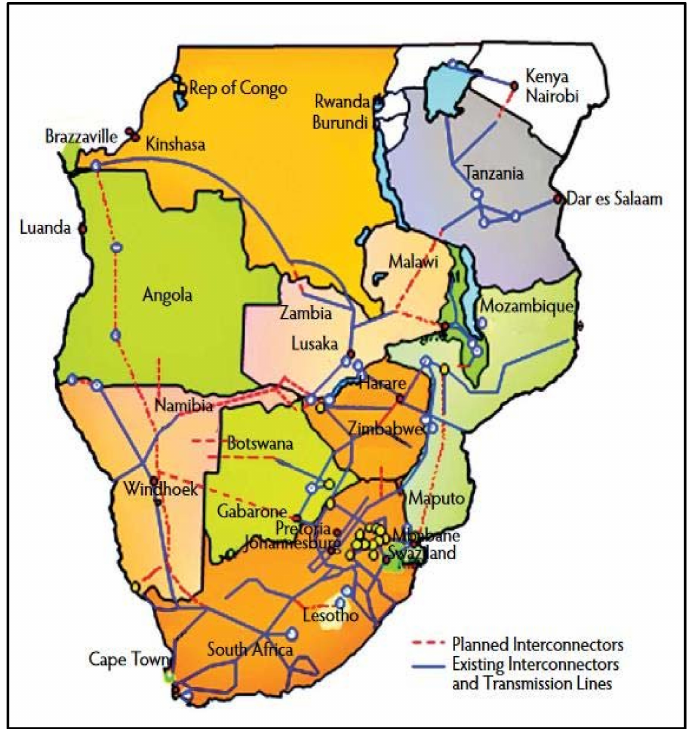
Figure 6. Distribution of energy infrastructure in shared watercourses in the SADC. Source: SAPP